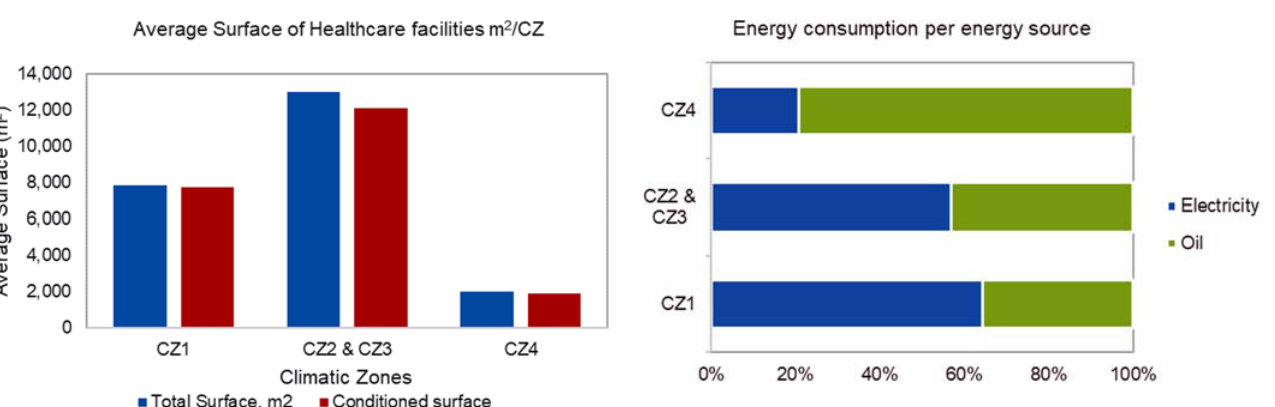
Fig. 2. Average building surface area of healthcare facilities under study in each climatic zone (m 2 ).